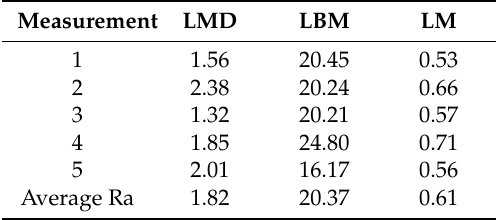
Table 9. Arithmetic Mean Deviation of the Roughness Profile (Ra) in microns, according to ISO 4287. 0.25 mm Gaussian filter applied.